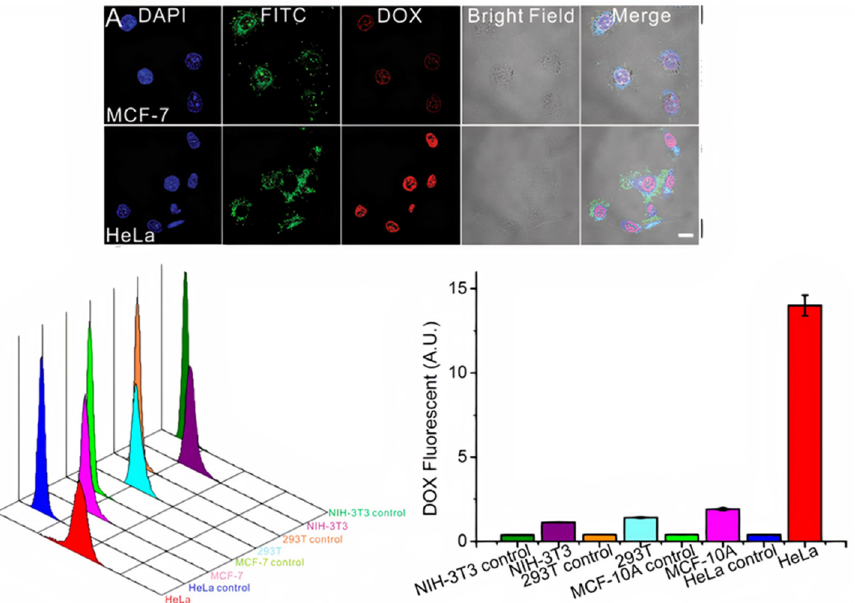
Figure 7. Top: Confocal microscopy images of the cellular uptake of fluorescently labeled FA- AuNR@RGD-DOX-Exos. MCF-7 ( ανβ 3+ and FR+) cells and HeLa ( ανβ 3+ and FR+) cells were treated with fluorescently labeled macrophage exosomes for 4 h. Bottom: Flow cytometric profiles and mean fluorescence intensity of the normal cell lines NIH-3T3, 293T, and MCF-10A and cancer cell line HeLa upon incubation with macrophage exosomes [74]. Figure and caption reproduced with permission from Wiley.